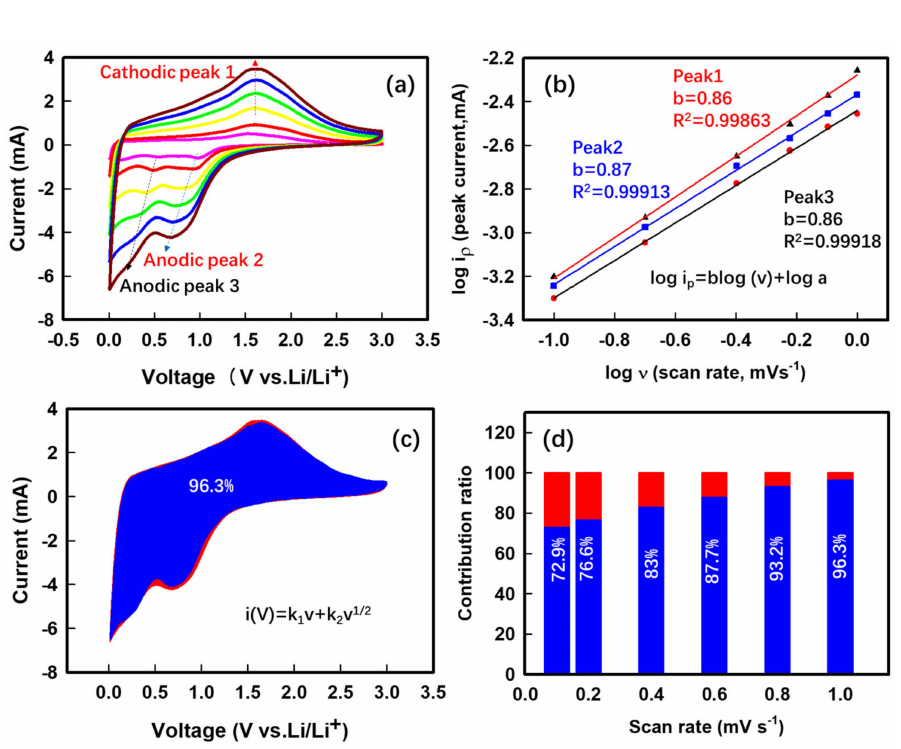
Figure 9. Charge-storage kinetics analysis of the Li + storage behavior of the proposed HEMO3 electrode. ( a ) CV curves for HEMO3 electrodes intended for LIB applications at different scan rates of 0.1 to 1.0 mV s − 1 . ( b ) Relationship curves between the peak current and scan rate that determine b -values. ( c ) Contribution of capacitive (blue region) and diffusion (red region) at scan rate of 1.0 mV s − 1 . ( d ) Ratio of capacitive- and diffusion-controlled percentage for the HEMO3 electrode at different scan